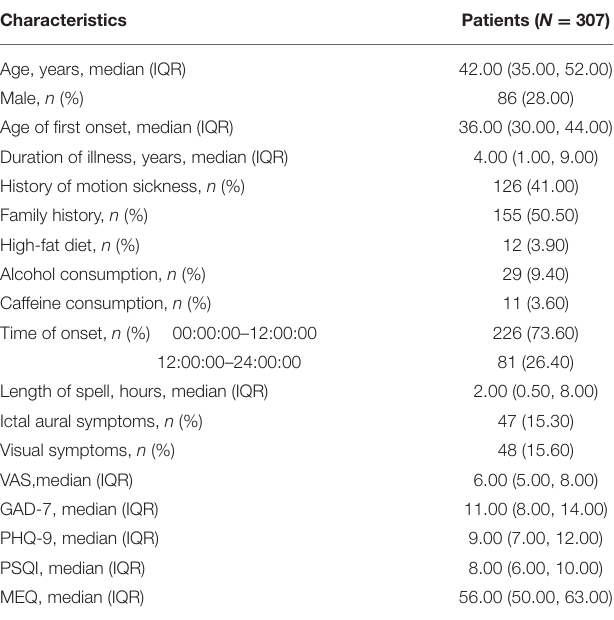
TABLE 2 | The characteristics of patients with VM. Characteristics